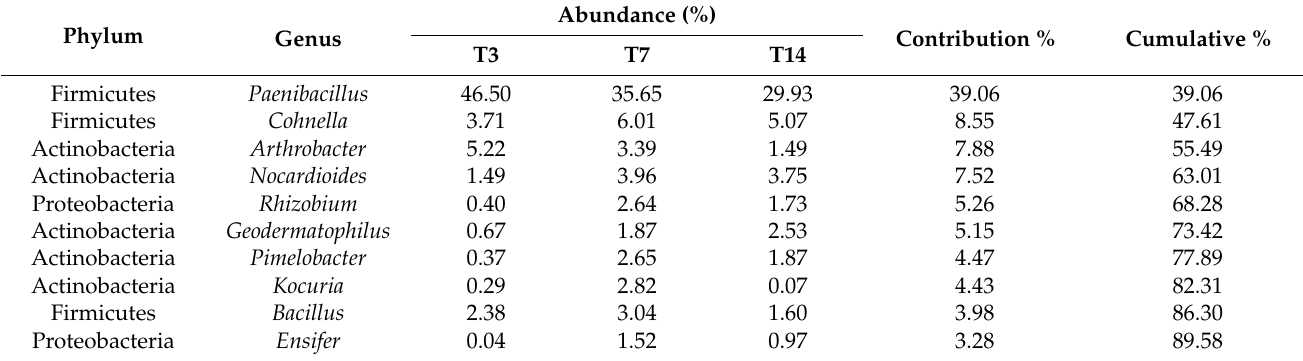
Table 3. Similarity percentage analysis (SIMPER) showing (i) the relative abundance of each identified genus and the corresponding phylum, (ii) the contribution to the total diversity and, (iii) the cumulative contribution to the average similarity. Contributions below 3% are not